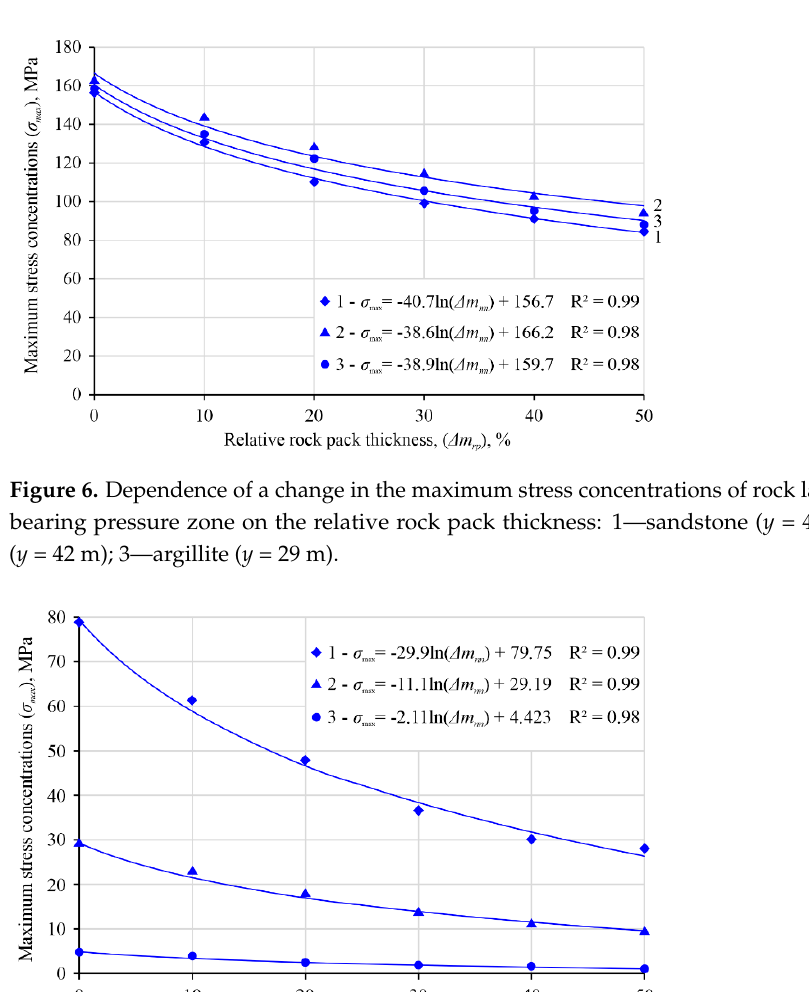
Figure 6. Dependence of a change in the maximum stress concentrations of rock layers in the frontal bearing pressure zone on the relative rock pack thickness: 1—sandstone ( у = 45 m); 2—siltstone ( у = 42 m); 3—argillite ( у = 29 m).